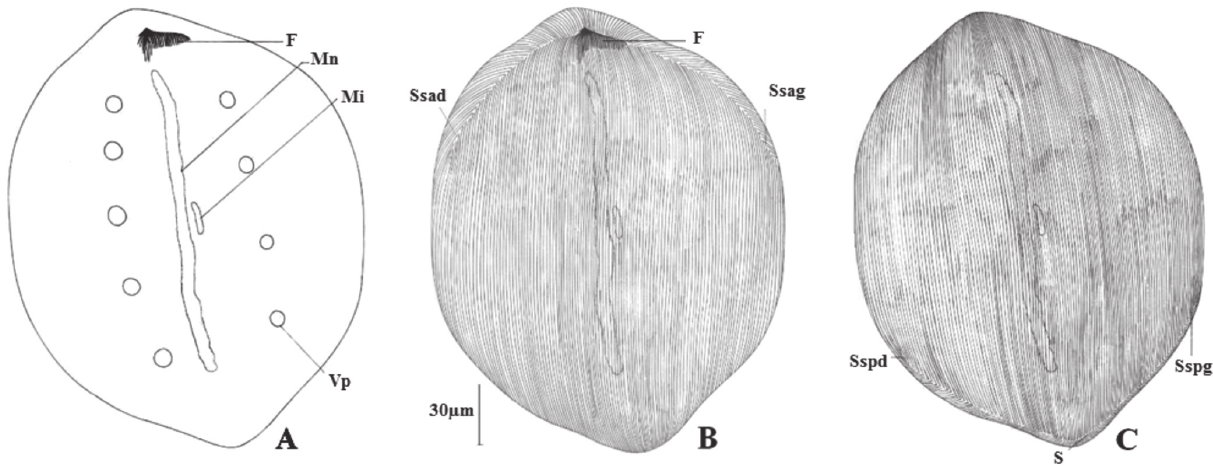
Figure 4. – Paracoelophrya ebebdensis n.